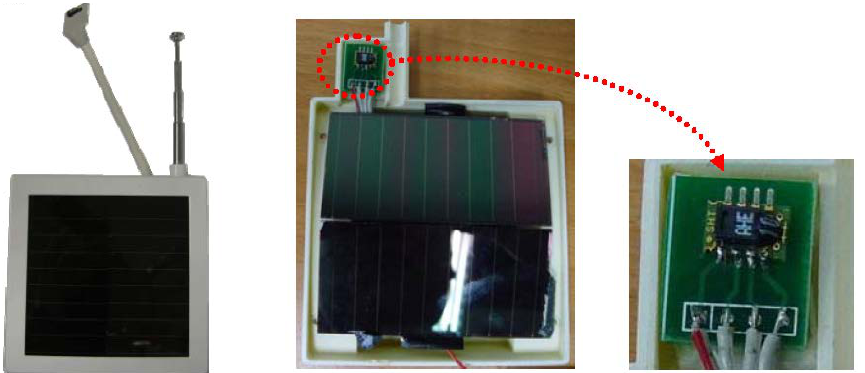
Figure 6. Sensor node.